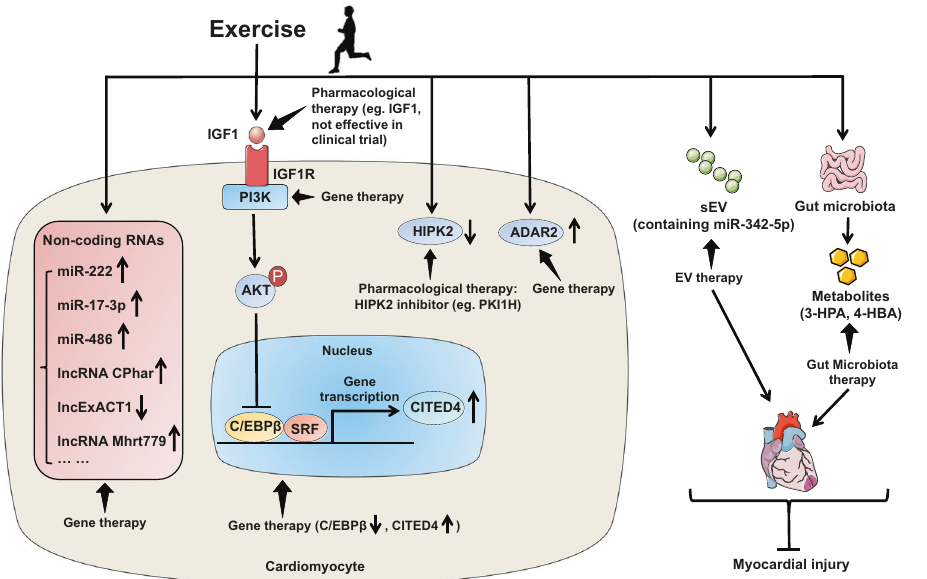
Fig. 7 A schematic diagram of the potential therapeutic strategies based on exercise-regulated signaling pathways. Pharmacological therapy and gene therapy can target exercise-regulated signaling pathways (e.g., IGF1/PI3K/AKT, C/EBP β /CITED4, noncoding RNAs, HIPK2, and ADAR2) to exert cardioprotective effect. Meanwhile, exercise-regulated small extracellular vesicles and gut microbiota as well as related metabolites can be applied to be potential therapeutic strategies for myocardial injury. IGF1 insulin growth factor 1, IGFR1 insulin growth factor 1 receptor, PI3K phosphoinositide-3 kinase, AKT protein kinase B, C/EBP β CCAAT/enhancer binding protein β , SRF serum response factor, CITED4 CBP/ p300-interacting transactivator with ED-rich carboxyterminal domain 4, HIPK2 homeodomain-interacting protein kinase 2, sEV small extracellular vesicles, 3-HPA 3-hydroxyphenylacetic acid, 4-HBA 4-hydroxybenzoic